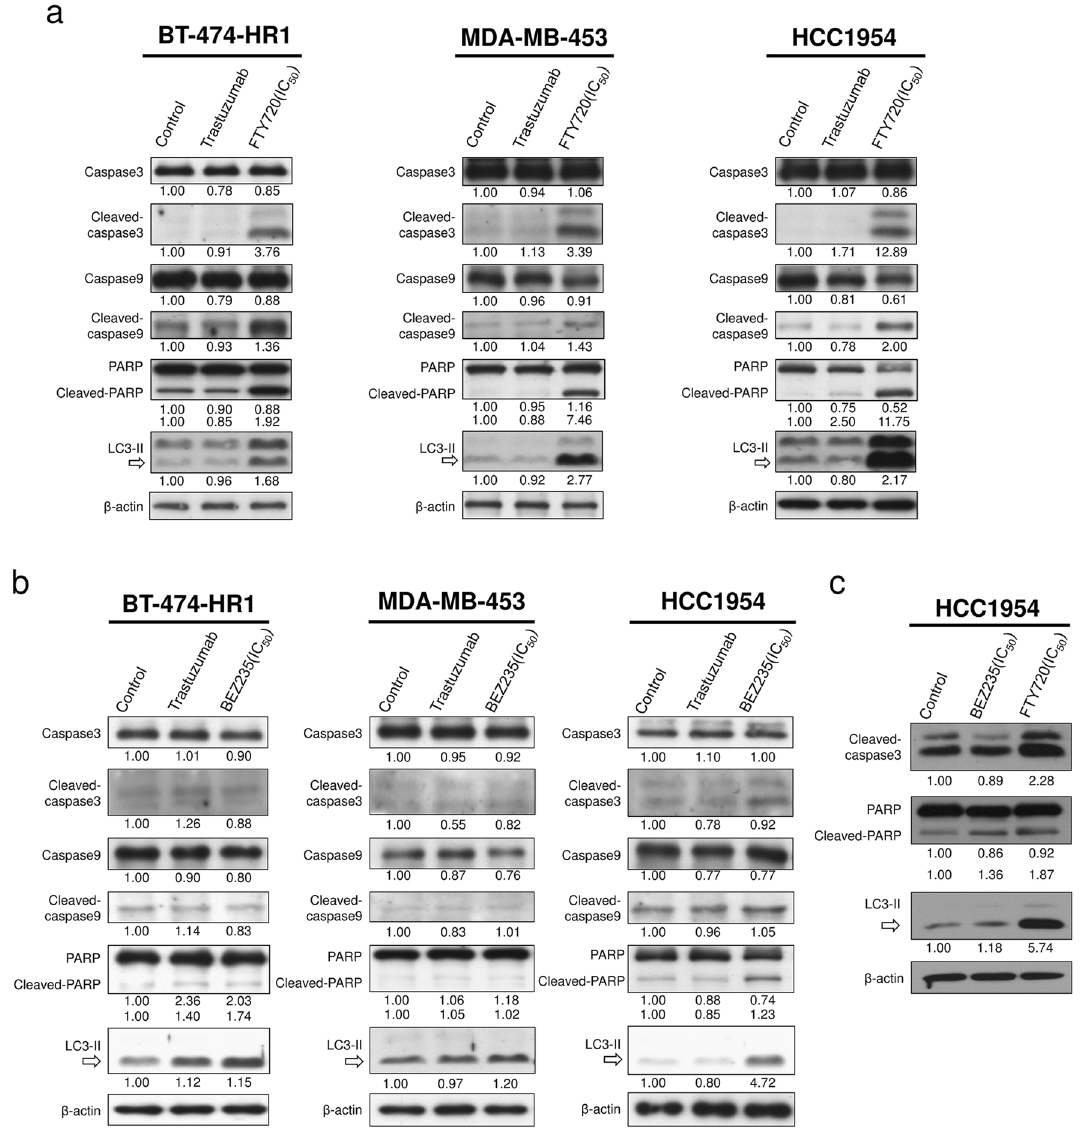
Figure 3. FTY720 induces apoptotic and autophagic signaling that is more potent than that of BEZ235. ( a ) Lysates were collected 24 h after trastuzumab or FTY720 treatment and then subjected to immunoblotting with the indicated antibodies. ( b ) Lysates were collected and evaluated 24 h after trastuzumab or BEZ235 treatment. ( c ) Protein expressions with BEZ235 and FTY720 were compared at IC 50 24 h after treatment in HCC1954 cells. FTY720 concentrations were 7.5, 7.5, and 10 μM for BT-474-HR1, MDA-MB-453, and HCC1954, respectively. BEZ235 concentrations were 16, 16, and 64 nM for BT-474-HR1, MDA-MB-453, and HCC1954, respectively. Equal loading of lysates was verified using the amount of beta-actin. Numbers under each Western blot represent the intensity of the protein relative to that of the control. All experiments were repeated at least three